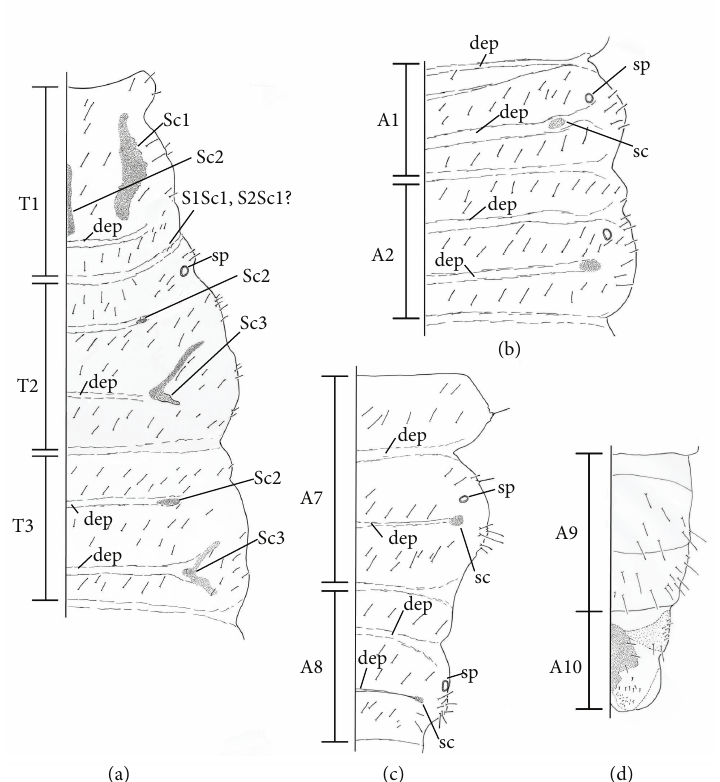
Figure3:Thoraxandabdomen(dorsal)of Hypochrysaafricana Kimmins,secondinstar.(a)Thorax.(b)Firstandsecondabdominalsegments. (c) Seventh and eighth abdominal segments. (d) Ninth and tenth abdominal segments. Abbreviations: Ax, number of abdominal